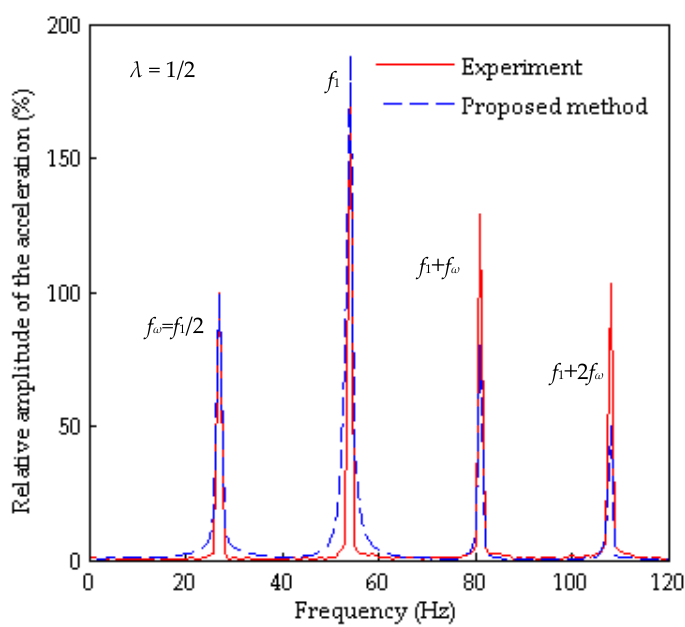
Figure 10. FFT spectrum of the transverse acceleration at the tip of the cracked beam with λ = 1/2.